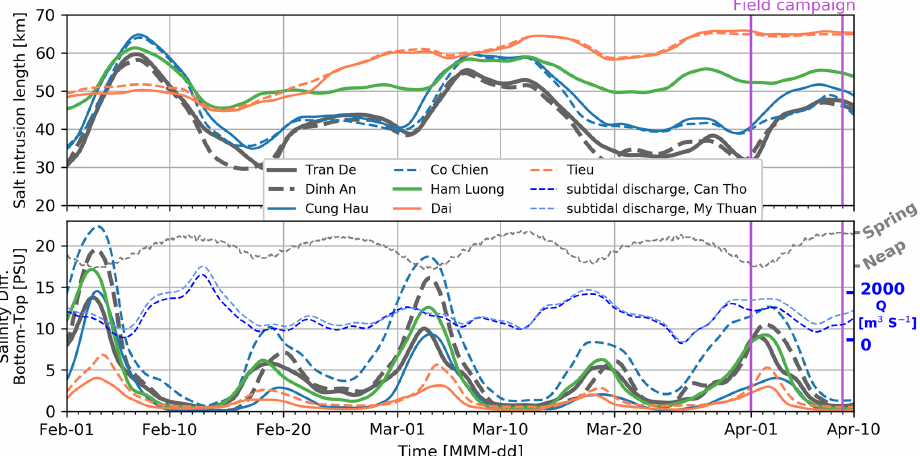
Figure 6. Modelled salt intrusion length along seven estuarine distributary channels of the Mekong (upper) and over-depth salinity difference at a point along the thalweg ∼ 15km from each estuarine distributary channel